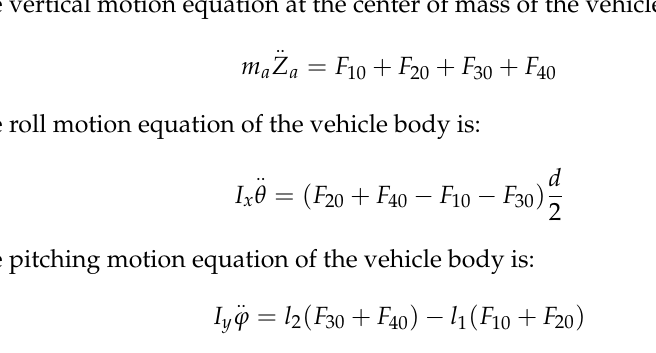
Figure 2. Mechatronic inertial suspension.